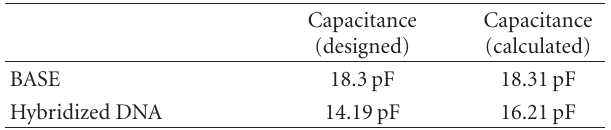
Table 2: The capacitance calculated from the circuit models (LPF and CF) for high resistance sensors.